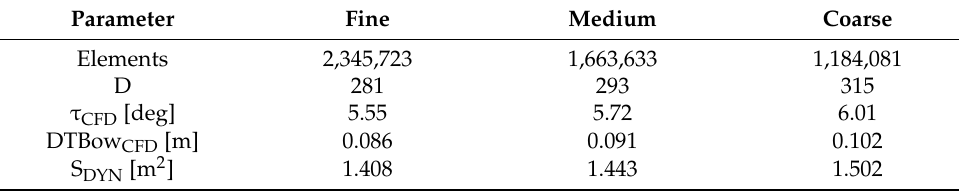
Table 5. Number of elements and different result for different meshes.